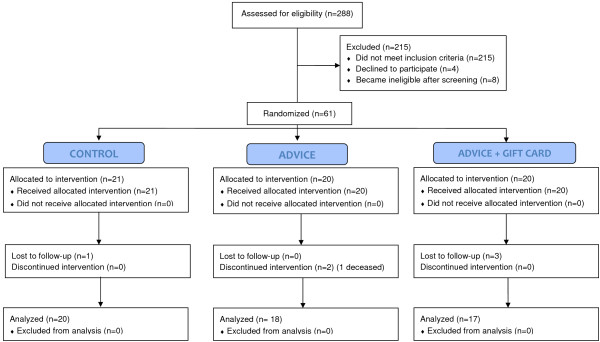
Flow diagram of Food for Thought participants from recruitment to 12-week follow-up.